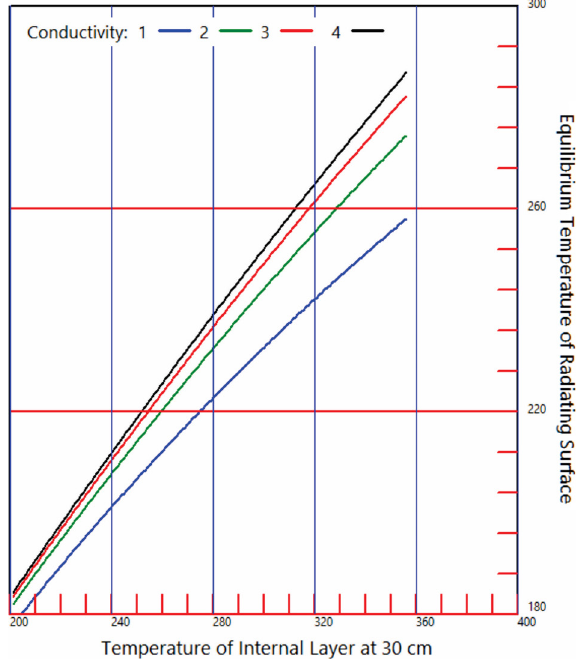
Fig. 4. Temperature of the radiating surface skin of the planet where the temperature of the internal layer at a depth of 30 cm varies from 200 to 350 K and for various assumed thermal conductivities of the soil ranging from 1 to 4 Wm −1 K −1